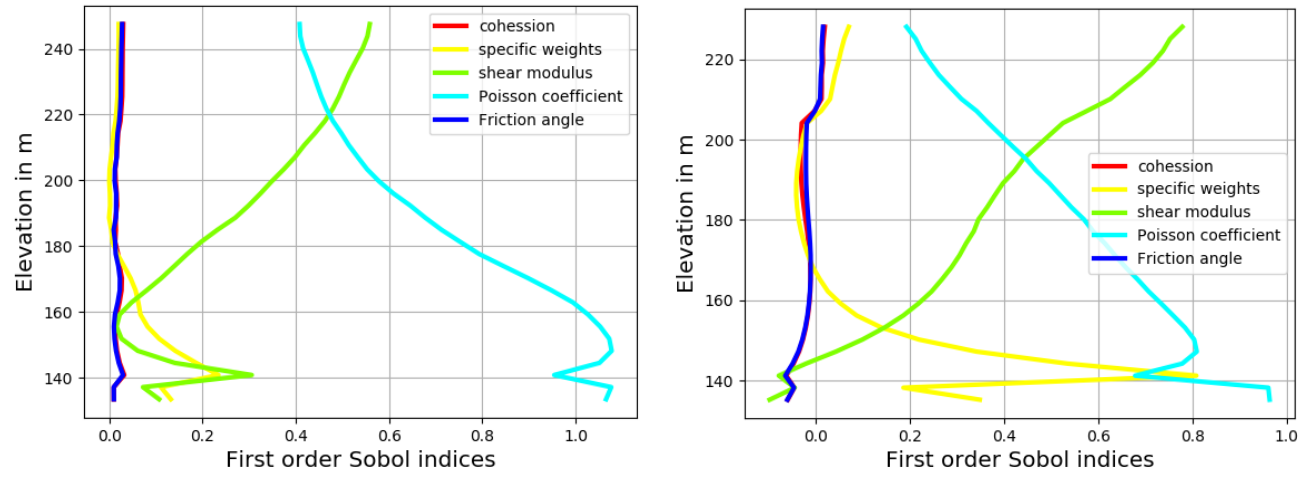
Figure 7. First Sobol variations with respect to the